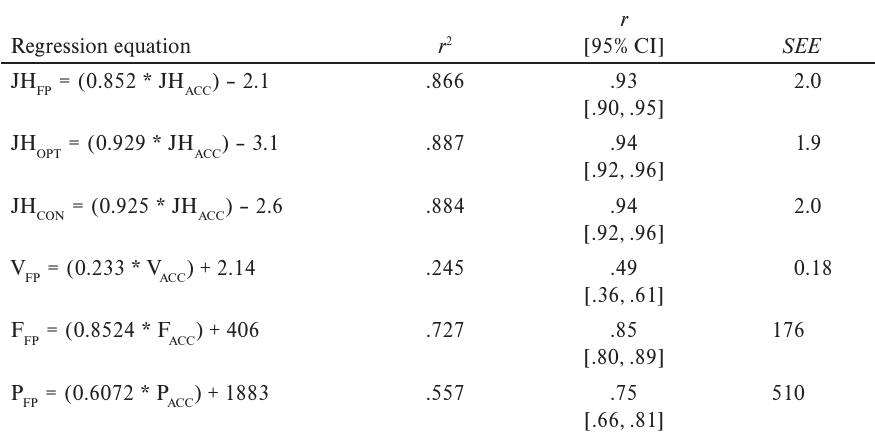
Correlations (r), goodness of fit (r 2 ), standard error of estimates (SEE) and regression equations for estimating jump height (JH), peak velocity (V), peak force (F), and peak power (P) from a Myotest accelerometer (ACC), force plate (FP), force plate contact time (CON), and Optojump